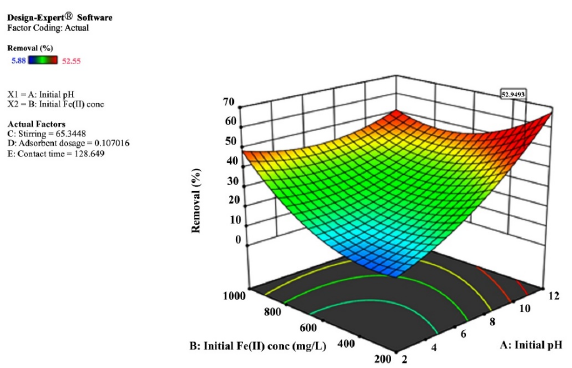
Fig. 7. Optimum value for the selected